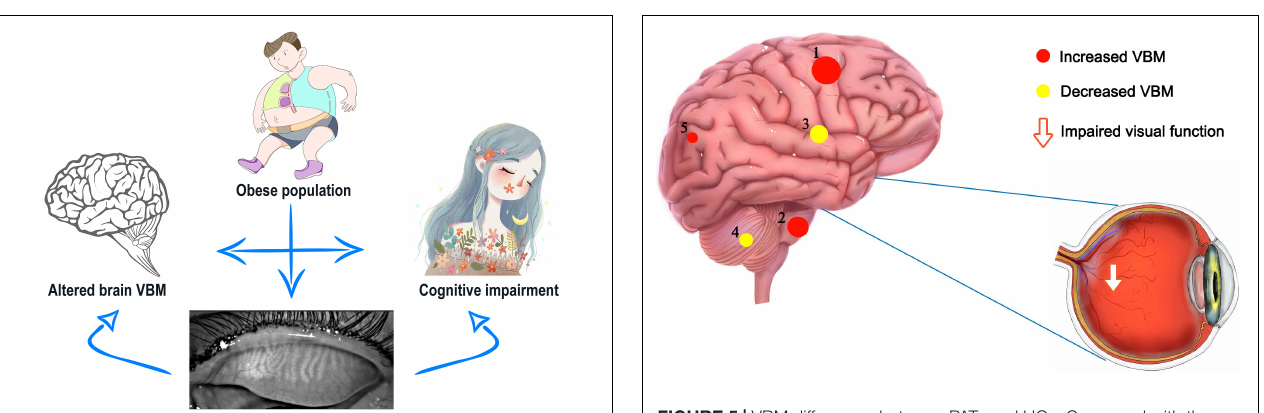
FIGURE 5 | VBM differences between PATs and HCs. Compared with the HCs, the following cerebral regions of PATs showed increased VBM values: 1-right paracentral lobule ( t = –11.35), 2-right brainstem ( t = –10.88), 5-right precuneus ( t = –5.87), and the following regions had decreased VBM values: 3-right thalamus ( t = 7.13), 4-left cerebellum ( t = 7.07). Abbreviations: VBM, voxel-based morphometry; PATs, severely obese patients with meibomian gland disease; and HCs, healthy controls.